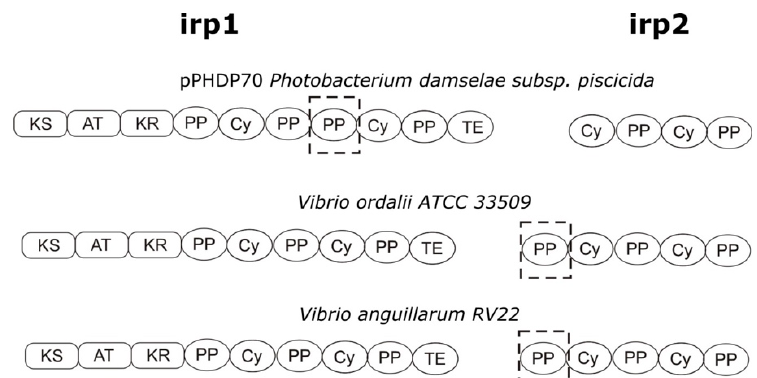
Figure 2. Representation of the catalytic domains predicted in Irp1 and Irp2 enzymes of Photobacterium damselae subsp . piscicida , V. ordalii ATCC 33509 T and V. anguillarum RV22. Analysis of domains was performed using the PKS/NRPS database (http://nrps.igs.umaryland.edu/). Abbreviations: AT, acyltransferase; Cy, cyclization; KS, ketoacil synthase; KR, ketoreductase; PP, peptidyl-carrier protein; TE, thioesterase. Dotted boxes highlight the main differences.